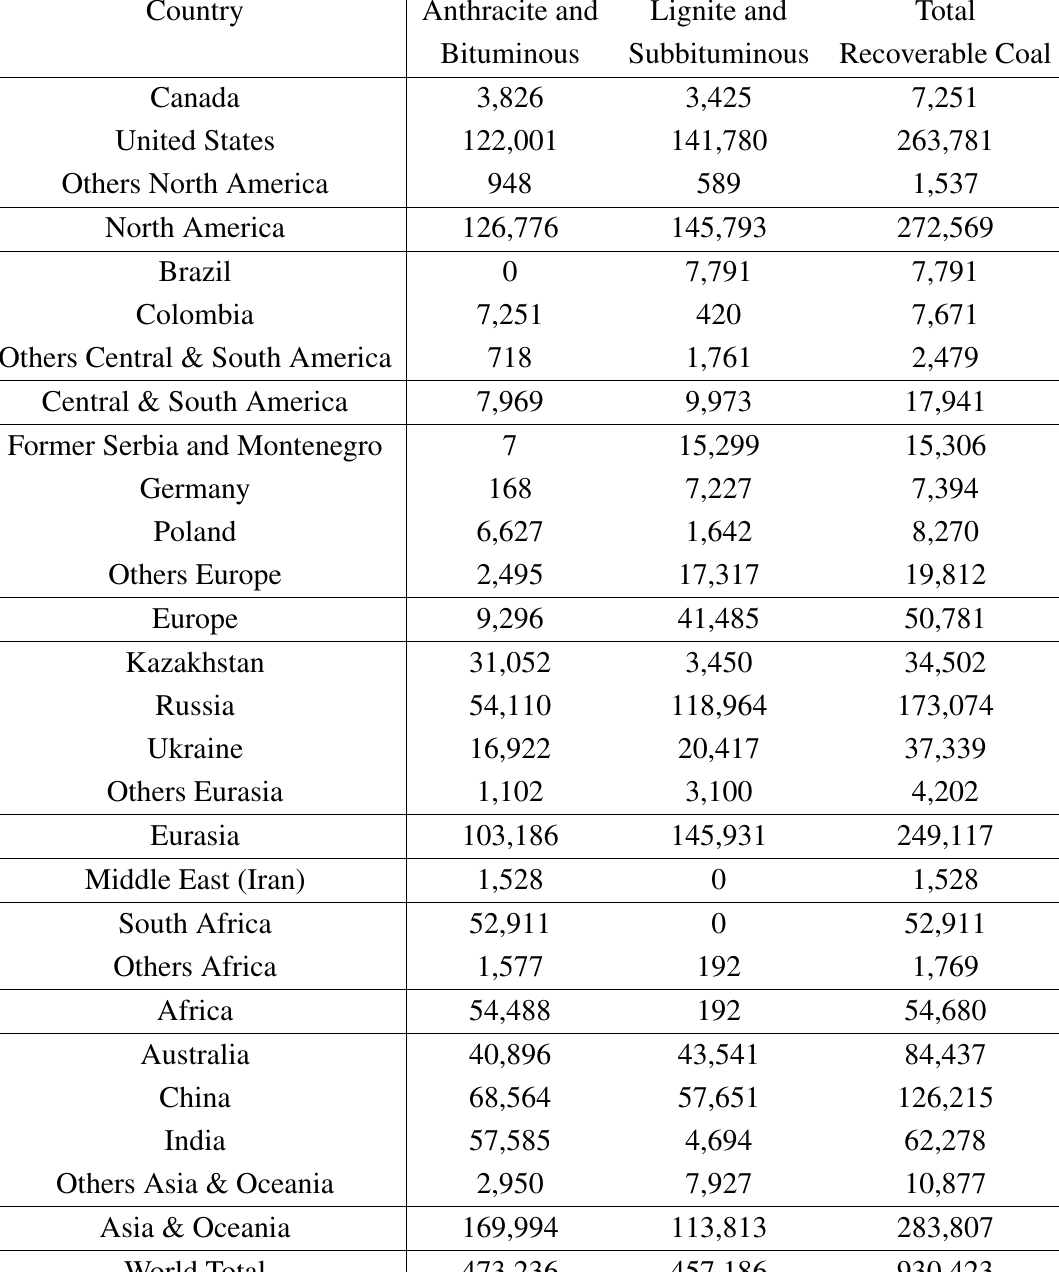
Table 2. Recoverable coal resources around the world (million short tons). Source: see note